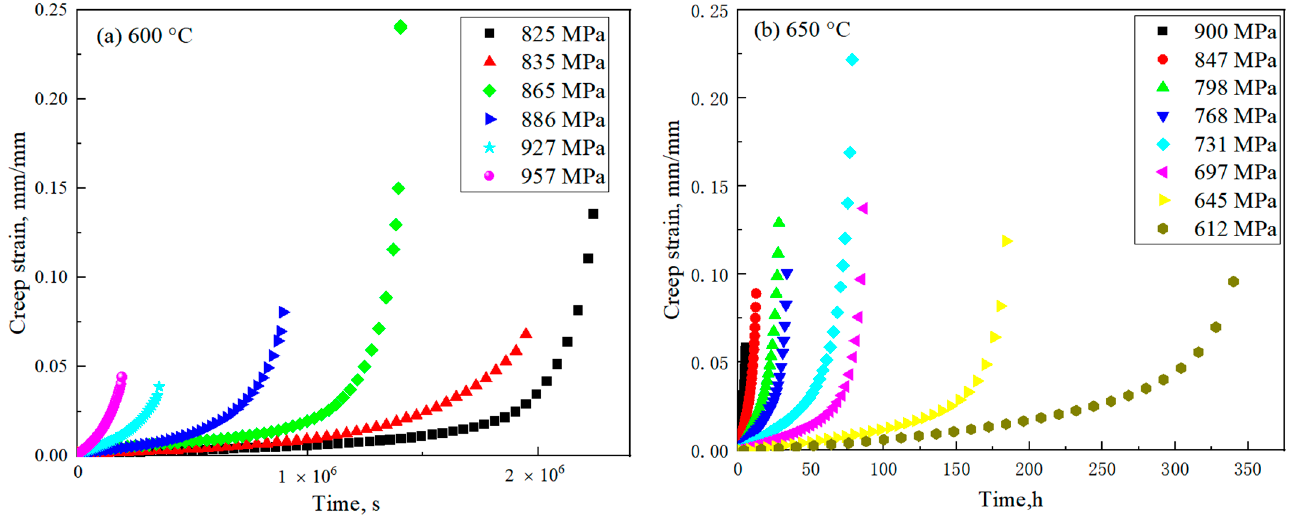
Figure 3. Creep strain–time curves of the GH4169 alloy at different temperatures: ( a ) 600 °C; ( b ) 650 °C.